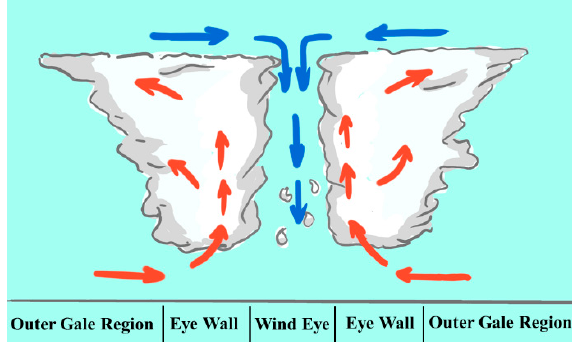
Figure 1. The schematic of typhoon structure.